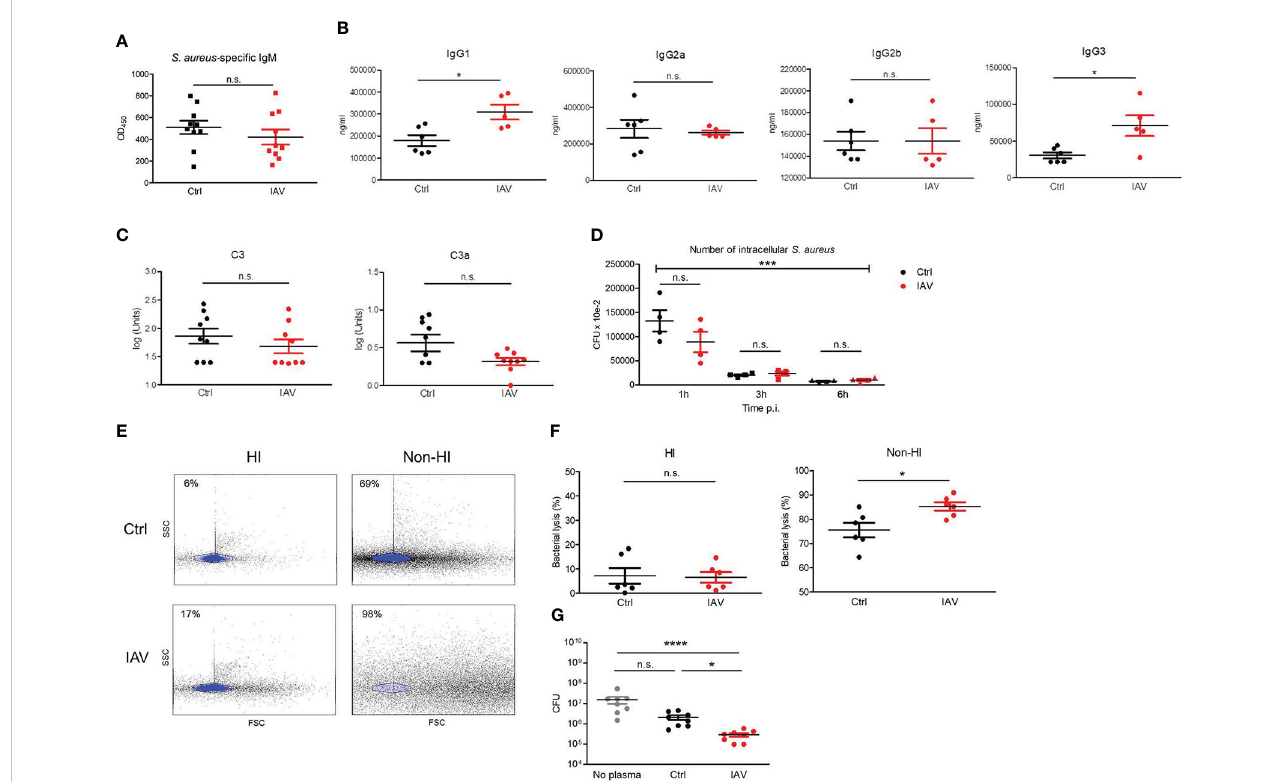
FIGURE 4 Silent neonatal exposure to IAV enhances humoral antimicrobial functions. Plasma was collected from d21 mice pretreated i.n. on d3 with PBS (Ctrl) or 5 PFU of IAV. (A) Levels of S. aureus -speci fi c IgM as determined by ELISA. OD 450 , optical density measured at 450 nm (Ctrl n = 10, IAV n = 10). (B) Plasma concentration of indicated murine IgG subclasses (Ctrl n = 6, IAV n = 5). (C) Complement levels of C3 and C3a (Ctrl n = 9, IAV n = 9). Bars represent means ± SEM. *p < 0.05 (MWU tests). (D) Opsonizing plasma activity was tested by preincubating S. aureus with heat-inactivated (HI) plasma from d21 mice of the Ctrl or IAV group (each n = 4). Opsonized bacteria were used at MOI 10 for infection of macrophages obtained from untreated adult C57BL/ 6 mice. Plotted is the number of CFU of intracellular S. aureus at 1 h, 3 h and 6 h p.i. Indicated is the overall signi fi cance of S. aureus elimination over time (***p < 0.0001, ANOVA) and differences between the pretreatment groups at respective time points p.i. ( post hoc ANOVA Tukey ’ s multaiple comparison tests). (E, F) Plasma-mediated bacterial lysis was determined fl ow cytometrically by analyzing the number of bacteria left after incubation of 1 × 10 7 CFU of heat-inactivated S. aureus with HI plasma and non-HI plasma obtained from d21 mice of the Ctrl and IAV group. (E) Representative FACS scatter plots with the gate of intact bacteria highlighted in blue. Indicated are the percentages of bacterial lysis. (F) Bacterial lysis was plotted as percentage of bacterial loss after treatment with HI and not-HI plasma compared to not plasma treated bacteria (Ctrl n = 6, IAV n = 6). Bars represent means ± SEM, *p < 0.05 (MWU test). (G) CFU of S. aureus after 1h of growth without plasma and in the presence of plasma from d21 mice of the Ctrl and IAV group (each n = 8). Bars represent means ± SEM, *p < 0.05, ****p < 0.0001 (Kruskal-Wallis test with post hoc Dunn ’ s multiple comparison tests). n.s., not signi fi